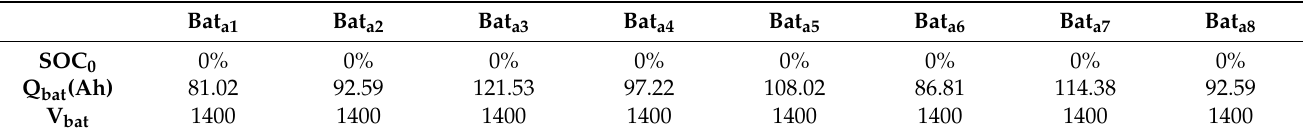
Table 2. Upper leg battery parameters of phase A.